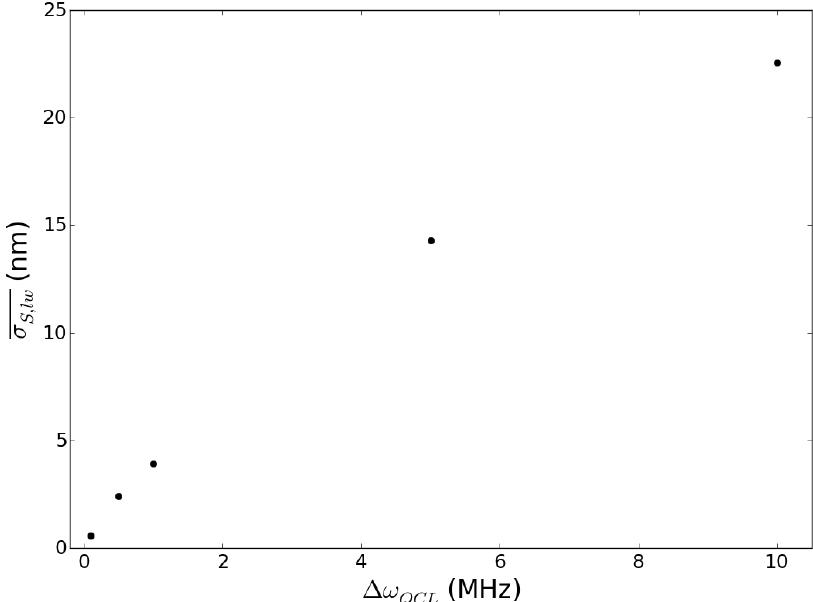
Figure 10. Plot of the uncertainty σ associated here with quantity ∆ ω